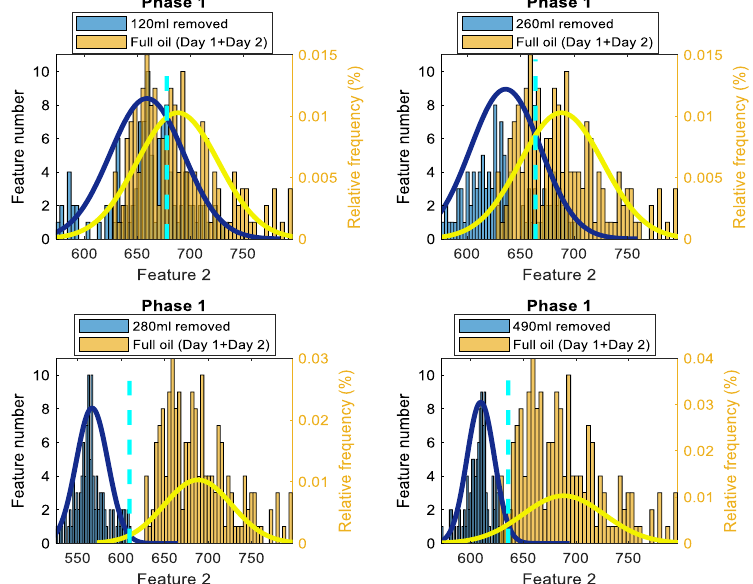
Figure A10. Histograms of Feature 2 for phase 1 of the current signals, comparing the standard oil level (Day 1 + Day 2) to 120 mL, 260 mL, 280 mL and 490 mL of removed oil cases.